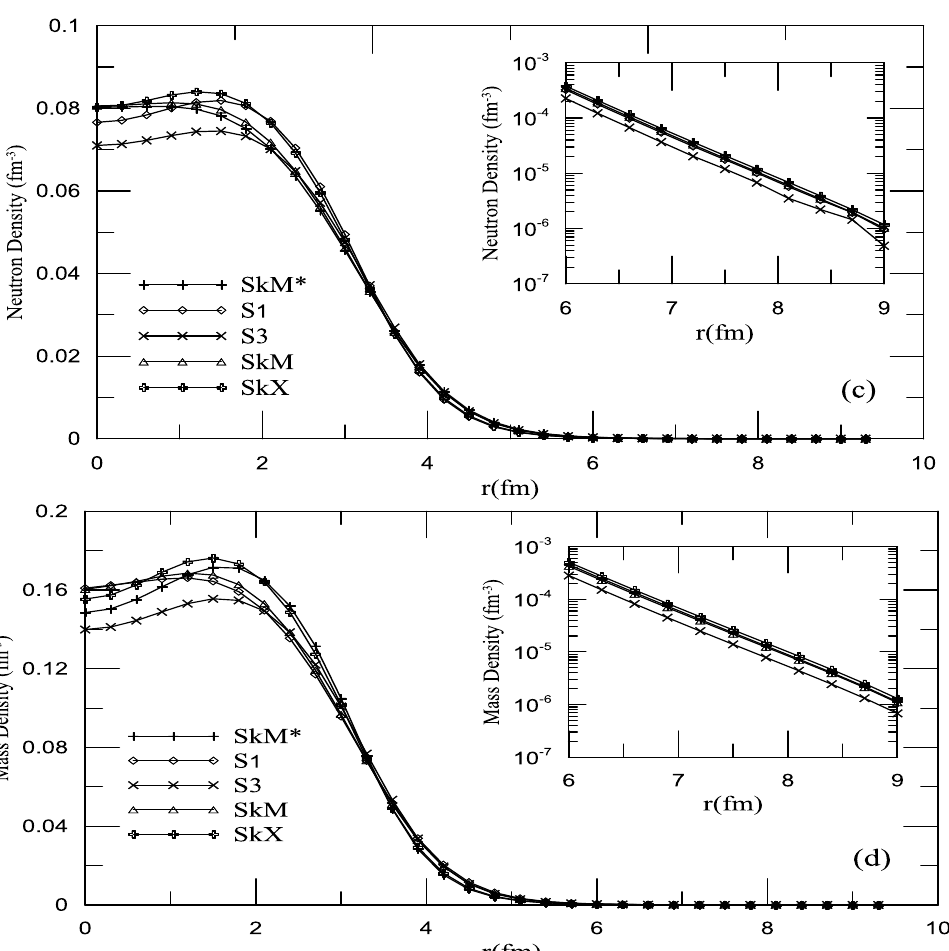
Fig.2: Density curves of 28 Si as functions of radii calculated by different Skyrme parameterizations; (c) neutron density, (d) mass